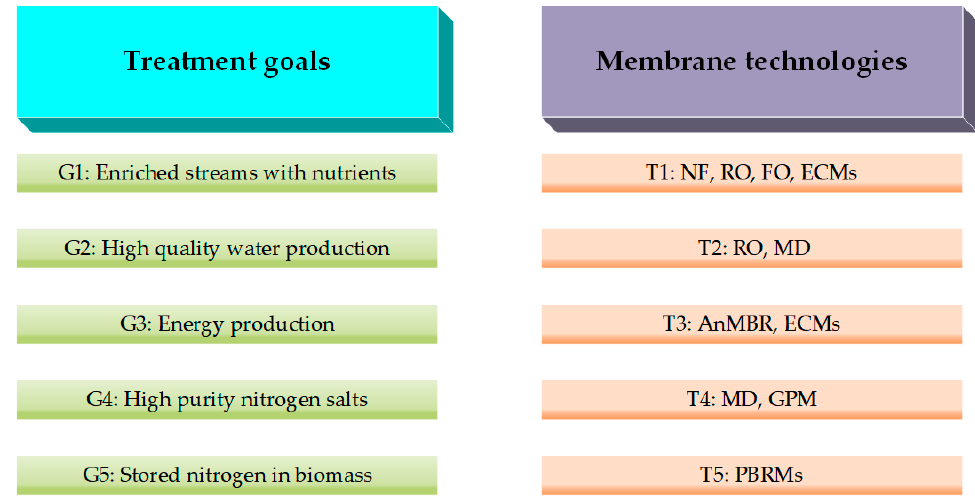
Figure 14. Membrane technology selection matrix based on the recovery goals. Table 9. Summary of energy requirements and performance of single and hybrid systems from technologies in T2-T4 groups as reported in the literature.